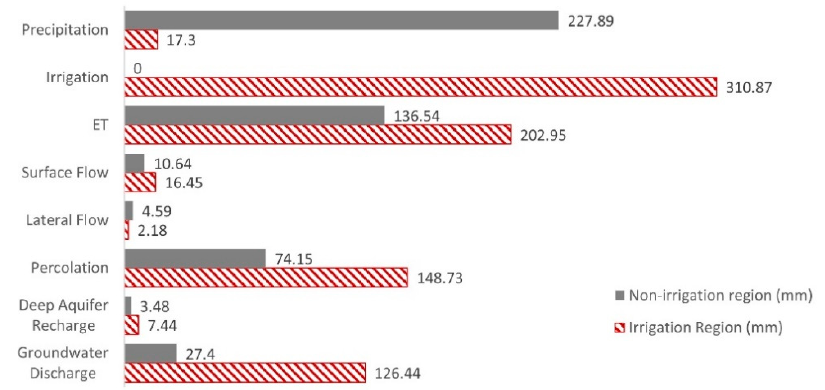
Figure 7. Average annual comparisons of hydrological elements as a percentage of precipitation for irrigation and non-irrigation regions.